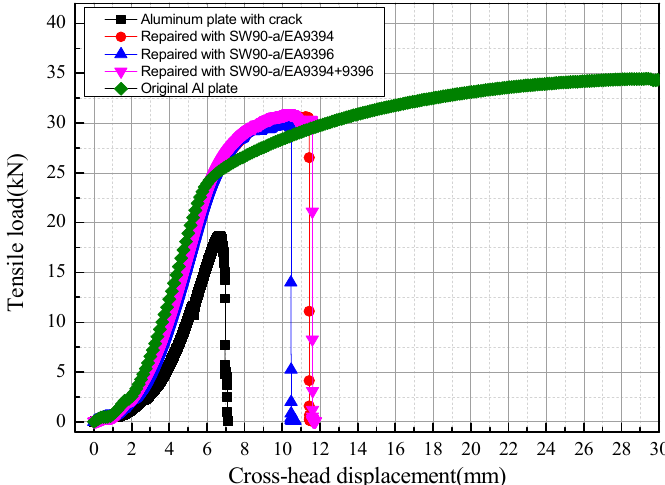
Figure 4. Typical tensile load-displacement curves of the GFRP-repaired cracked plates.